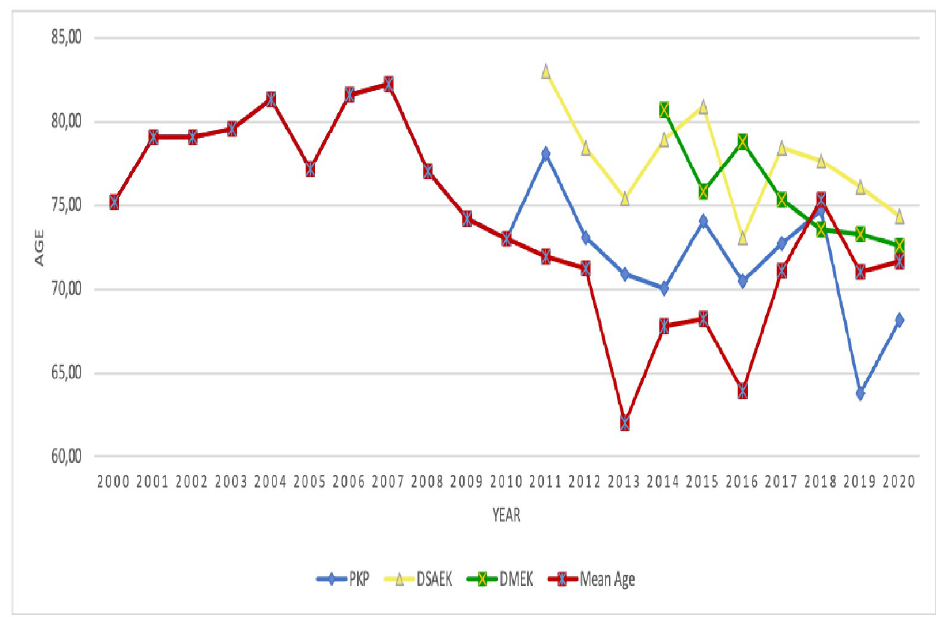
Fig 7. Changes in average patient age over time in the whole cohort and in patients undergoing PKP, DSAEK, and DMEK. DSAEK, Descemet stripping automated endothelial keratoplasty; DMEK, Descemet membrane endothelial keratoplasty; PKP, penetrating keratoplasty.